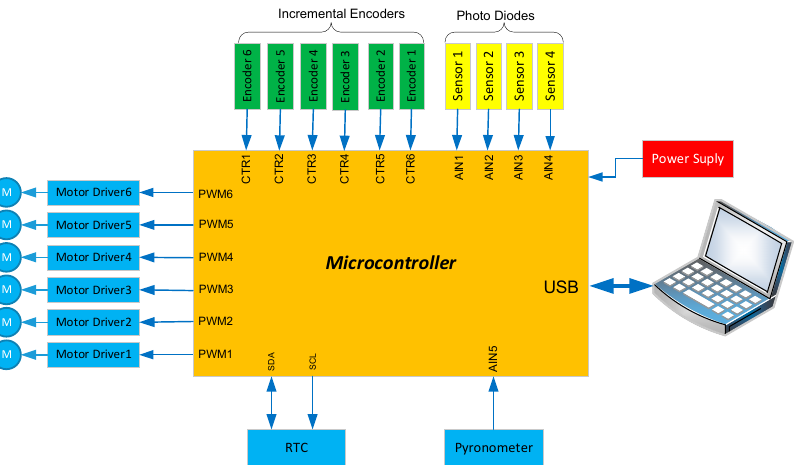
Figure 8. Hardware architecture of the embedded controller.